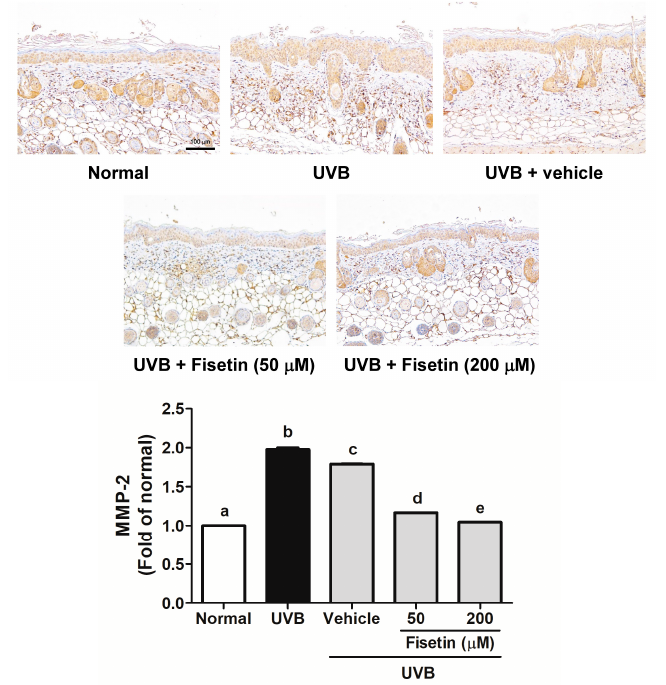
Figure 8. Immunohistochemical staining of MMP-2 expression in the dermis of the mouse skin slices. Fisetin inhibits UVB-induced MMP-2 overexpression. a–e: Values not followed by a common letter are significantly different ( p < 0.05). Int. J. Mol. Sci. 2017 , 18 , 2118